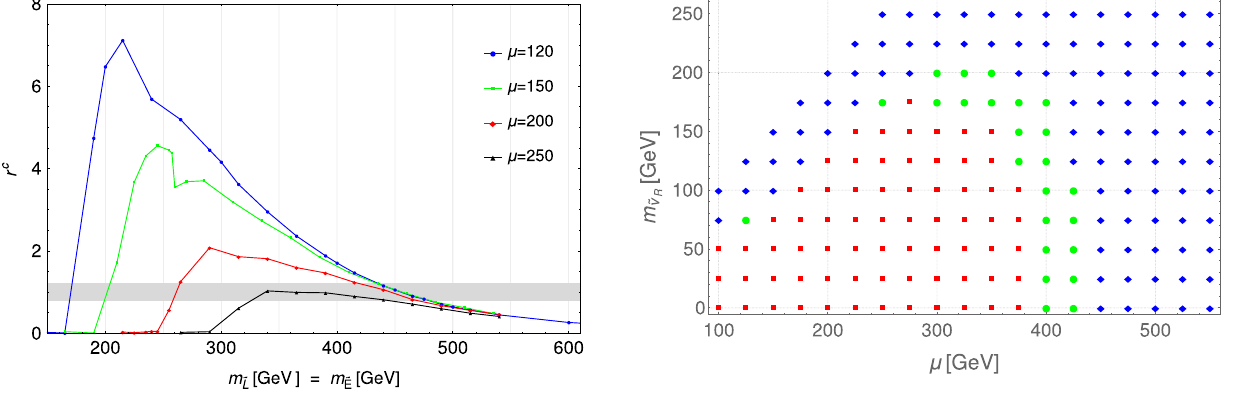
Fig. 5 r c as a function for tan β = 10, M 1 = M 2 = 1 TeV and μ = 120, 150, 200 and 250 GeV, respectively. The gray band (0 . 8 ≤